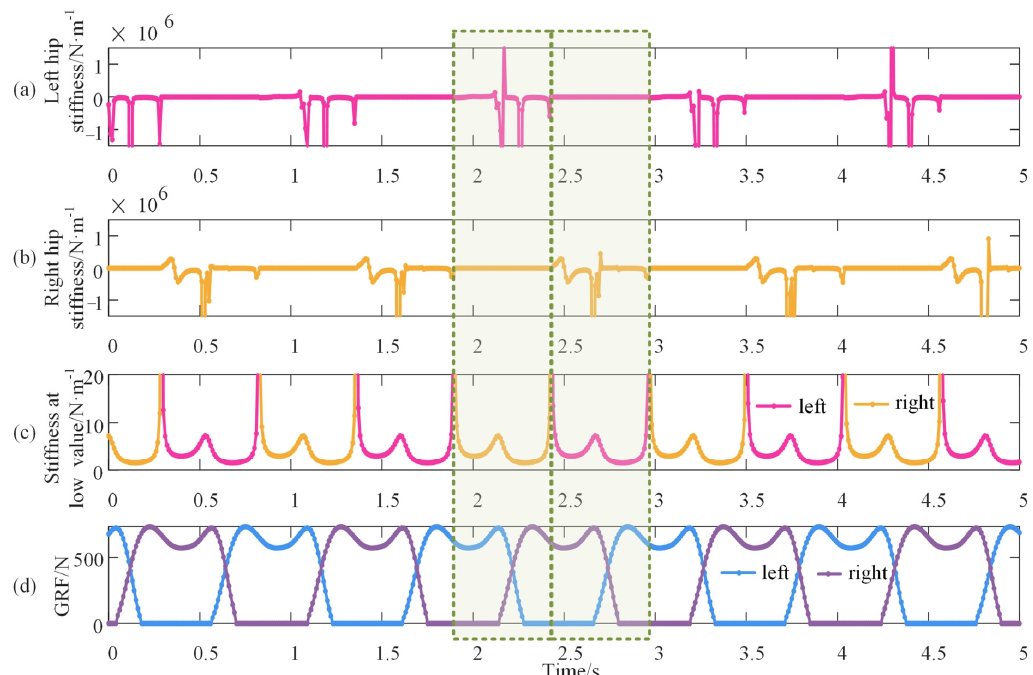
Figure 9. Vertical stiffness of the hip during walking. ( a , b ) denote the left and right hip, respectively, and it is evident that the fluctuation is rather high with a magnitude of 10 6 ; ( c ) shows the hip stiffness at the section of low value; and ( d ) is the vertical GRF of the double lower limbs. The green rectangles stand for half of the gait cycle.